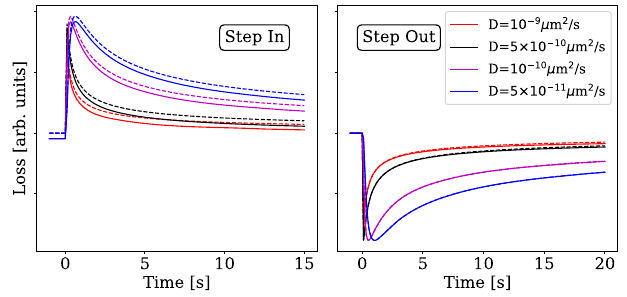
monitors.FIG. 1. Loss evolution for different values of the diffusion coefficient following Eqs. (2) and (3). Solid and dashed lines represent two approaches to the model simplification, described later in Sec.